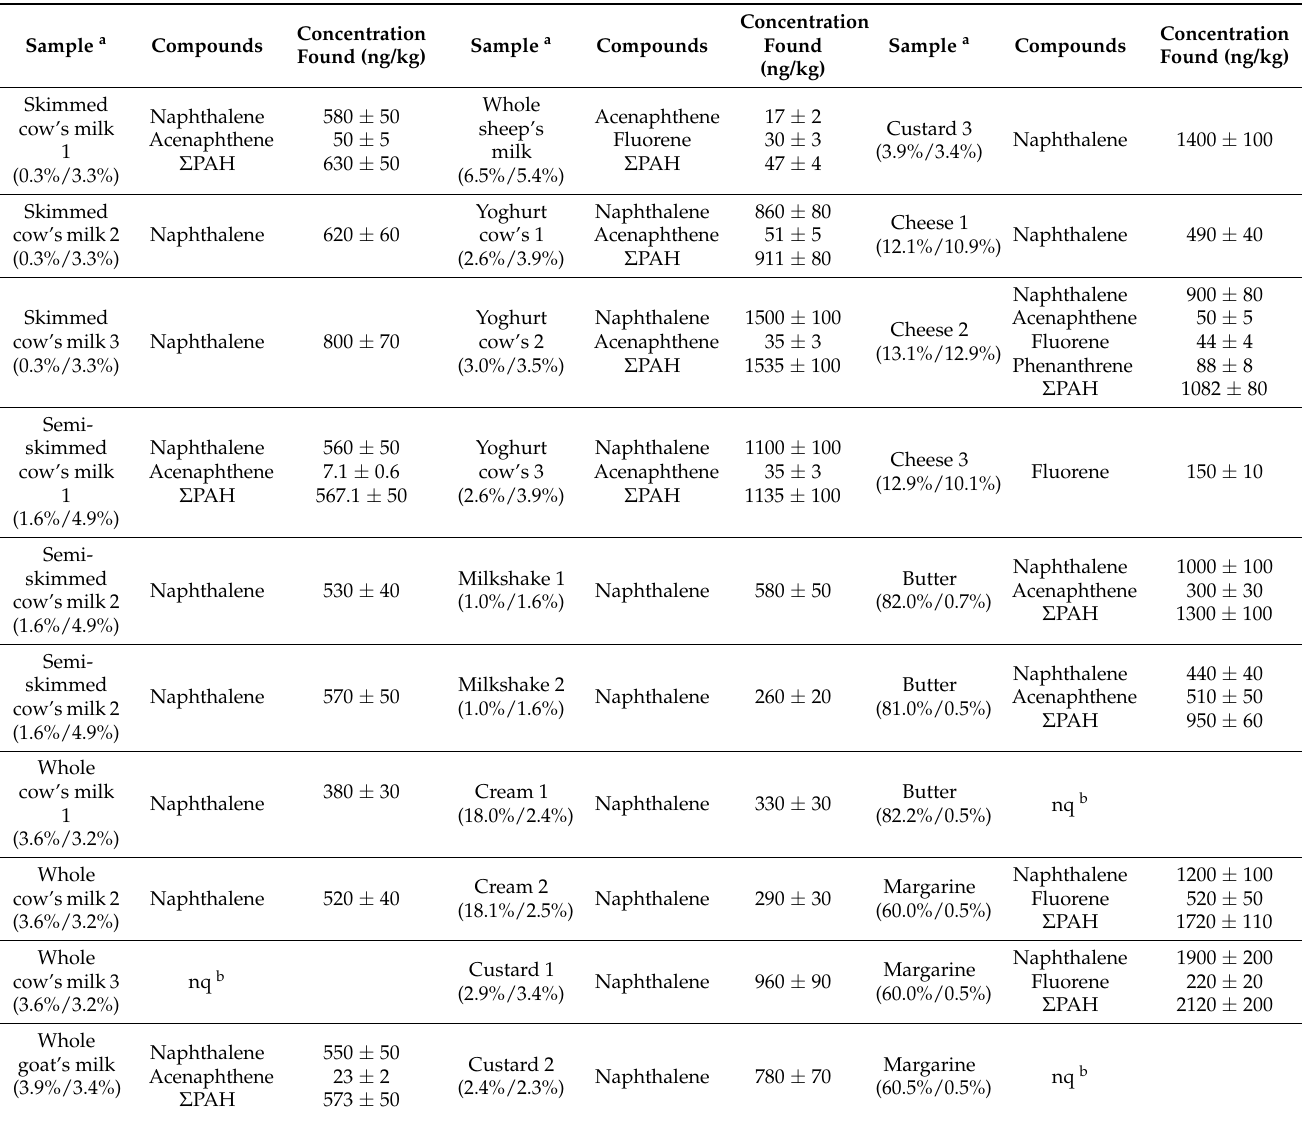
Table 4. Polycyclic aromatic hydrocarbons (mean values ± standard deviation, ng/kg) found in various types of milk samples and dairy products ( n =